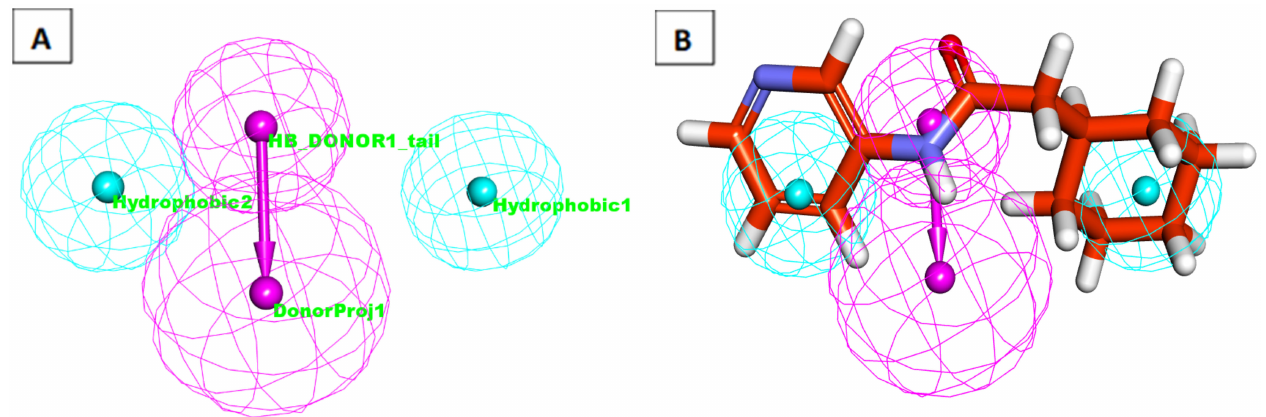
Figure 4. ( A ) Generated 3D-pharmacophore geometry with three features: one H-bond donor (pink color) and two hydrophobic centers (blue). ( B ) Mapping of the cocrystallized ligand on the generated pharmacophore (fit value =